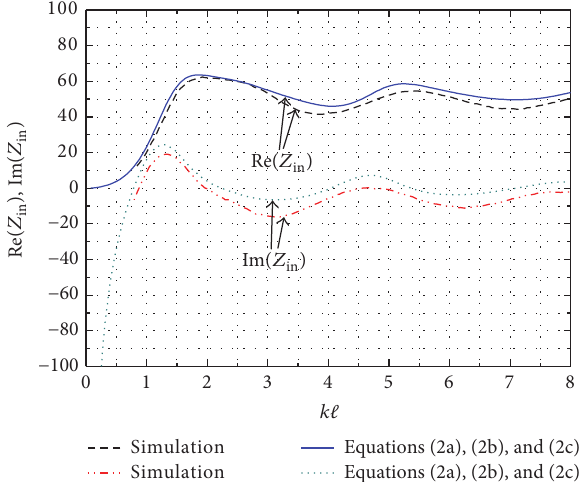
Figure 4: Geometry of a cone type monopole UWB antenna with a split loop.